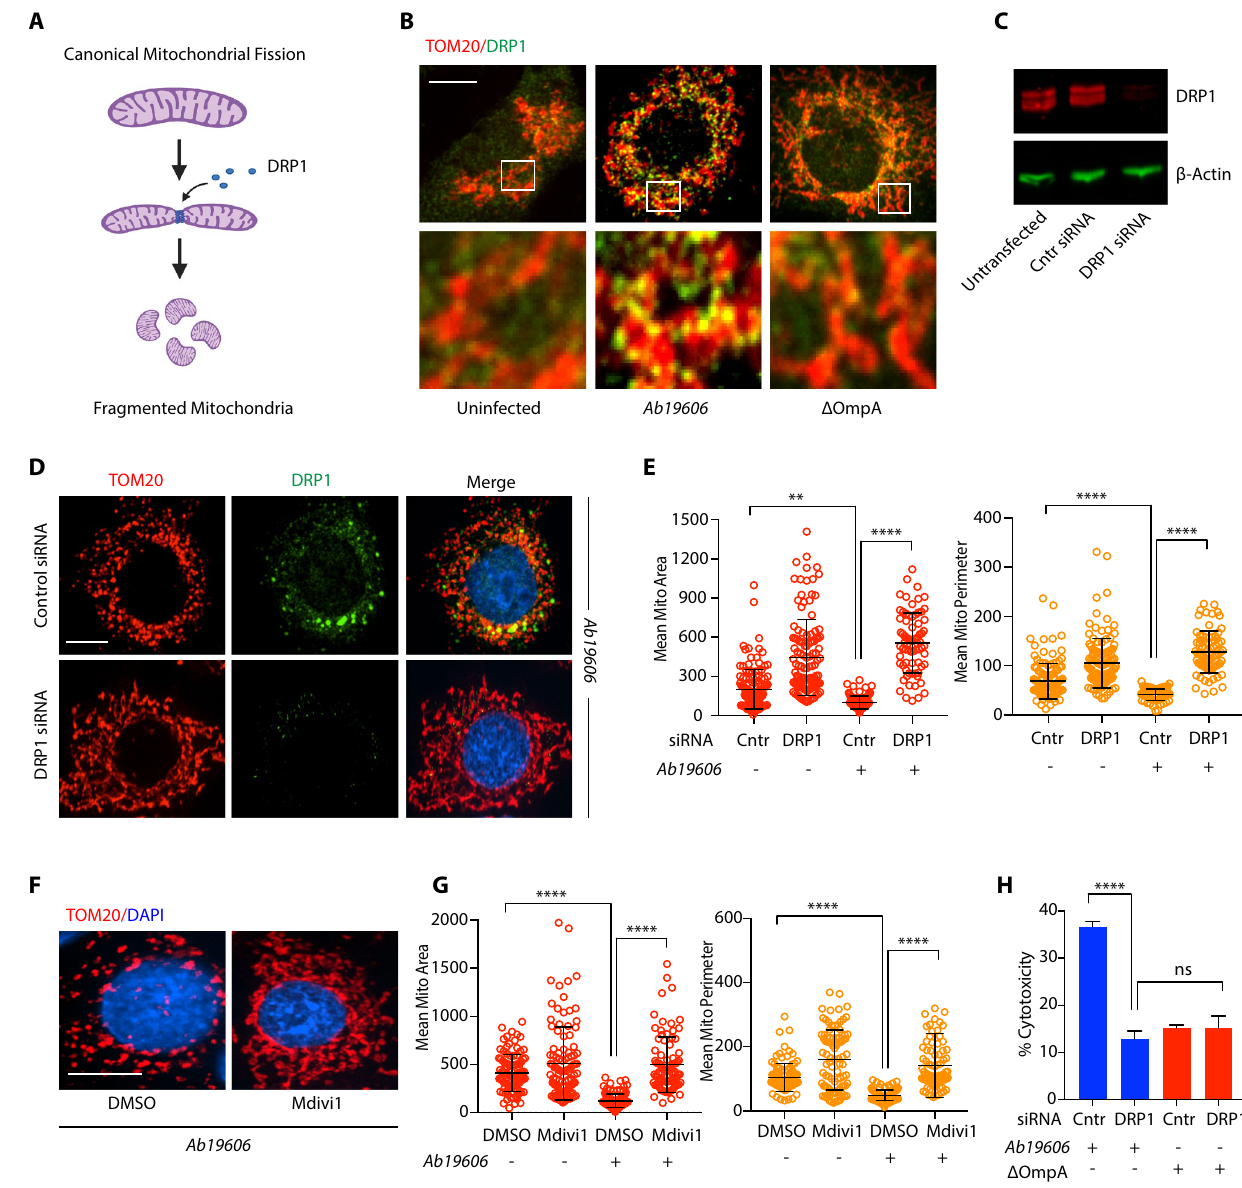
Figure 3. DRP1 is required for mitochondrial fragmentation upon A. baumannii infection. ( A ) The illustration represents the canonical mitochondrial fission pathway (created with BioRender.com). ( B ) A549 cells were infected with the indicated bacteria for 6 h at MOI 50. Immunofluorescence was performed using anti-TOM20 antibody to stain mitochondria (red) and anti-DRP1 antibody (green). Scale bar represents 10 µm. ( C ) Western blot on A549 cell lysates after indicated treatments. Anti-DRP1 antibody was used to examine DRP1 levels and ß-actin served as the loading control. ( D ) A549 cells treated with DRP1 siRNA or control (scrambled) siRNA were infected with wildtype A. baumannii (Ab19606) for 6 h at MOI 50. Immunofluorescence was performed using anti-TOM20 antibody to stain mitochondria (red), anti-DRP1 antibody (green) and DAPI to label the nucleus (blue). Scale bar represents 10 µm. ( E ) The scatter plots represent the quantification of mitochondrial area (red) and perimeter (orange). The experiment was performed in triplicates, n = 75–132 cells. Error bars represent standard deviation. One-way ANOVA with Tukey’s multiple comparisons test ** p ≤ 0.01, **** p ≤ 0.0001 ( F ) A549 cells pre-treated with Mdivi1 (10 µM) or DMSO control were infected with wildtype A. baumannii (Ab19606) for 6 h at MOI 50. Immunofluorescence was performed using anti-TOM20 antibody to stain mitochondria (red) and DAPI to label the nucleus (blue). ( G ) The scatter plots represent the quantification of mitochondrial area (red) and perimeter (orange). The experiment was performed in triplicates, n = 88–138 cells. Error bars represent standard deviation. One-way ANOVA with Tukey’s multiple comparisons test **** p ≤ 0.0001. ( H ) Cytotoxicity was assessed by LDH release assay after 6 h of infection in A549 cells treated with the indicated siRNA and bacteria. The experiments were done in triplicates. Error bars represent standard deviation. Two-tailed p value using unpaired t-test **** p ≤ 0.0001. % cytotoxicity was calculated by normalizing the LDH release in the infected groups with uninfected/untreated cells (representing no cytotoxicity) and TritonX-100 treated cells (representing the highest cytotoxicity). Mitochondrial area and perimeter quantifications were performed using an unbiased automated CellProfiler pipeline (see “Materials and methods” section for details). All the experiments shown here were performed three times